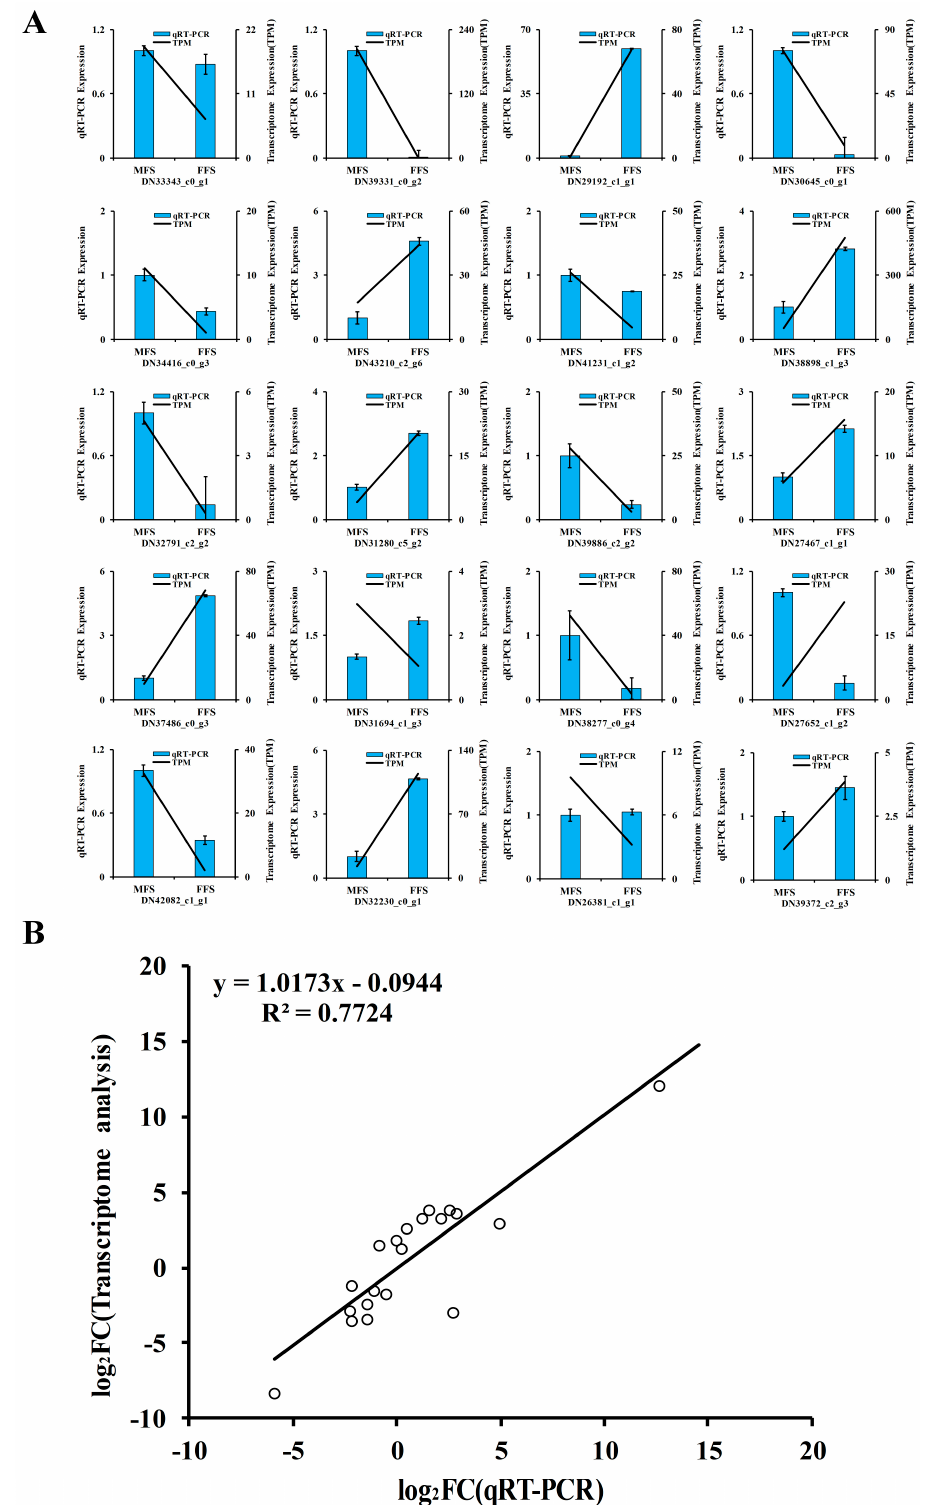
Figure 7. ( A ) qRT-PCR validation of the DEGs identified through high-throughput sequencing in females and male flowers; ( B ) correlation plot of the RNA-Seq results (TPM) and qRT-PCR (2- ∆∆ Ct) results. The values of log2(relative expression ratios) in qRT-PCR (x-axis) were plotted against the values of log2 (TPM ratios) in transcriptome data (y-axis) for the 20 selected